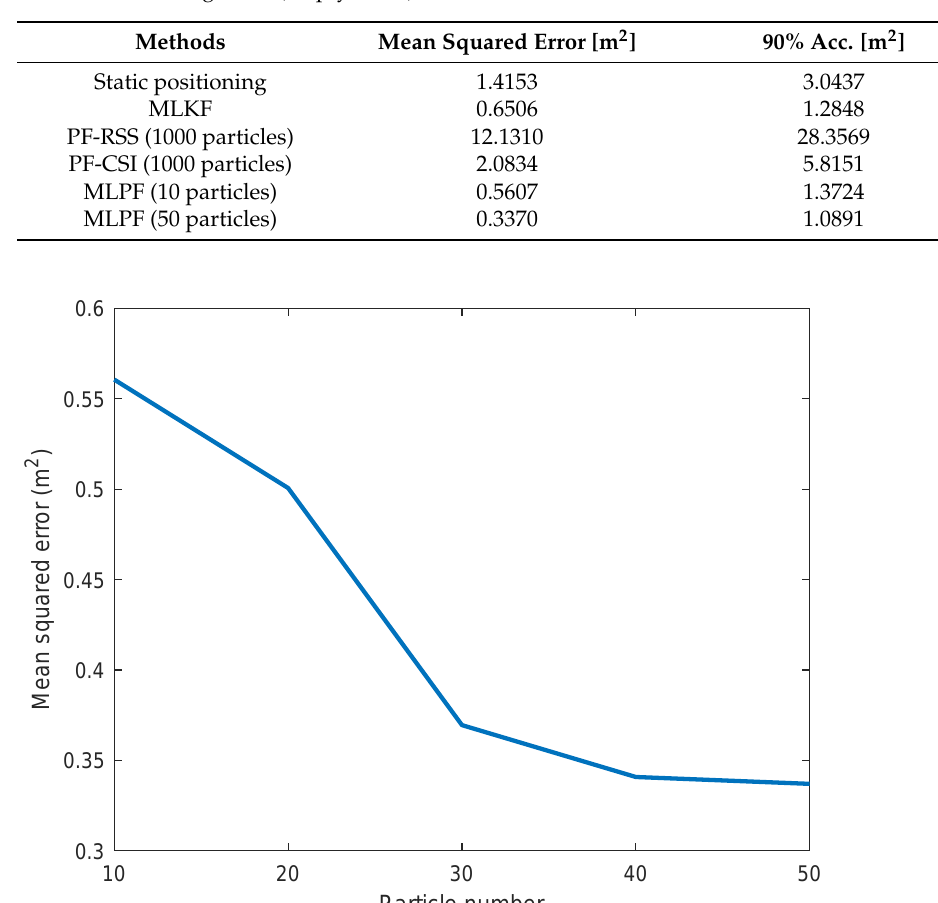
Figure 2. Layout and database points of the empty room. The access point (AP) is placed at the lower-right corner. Table 1. Positioning Error (empty room).